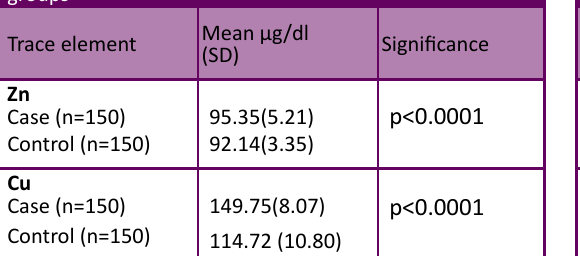
Table 2. Serum Zn and Cu levels in acute and chronic